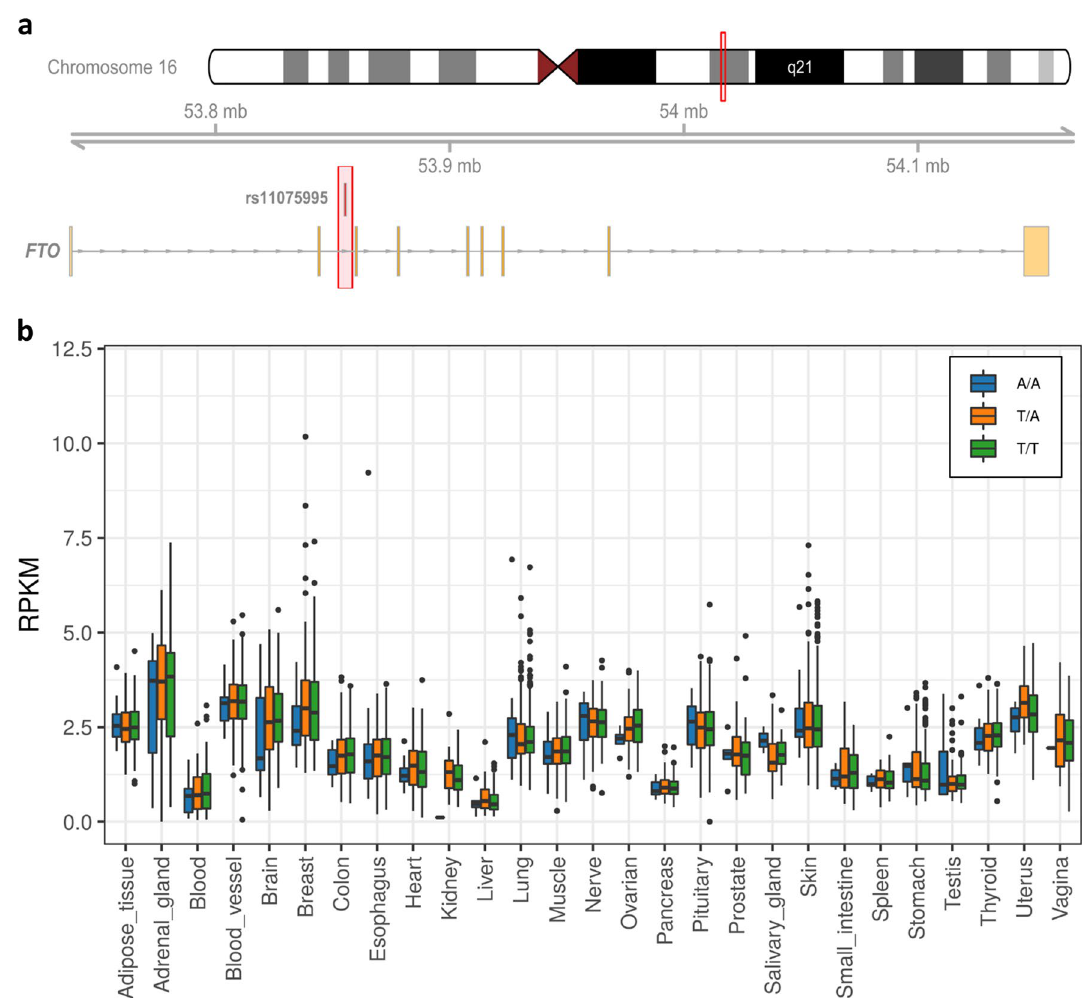
Figure 7. cis-effects of rs11075995 minor allele and FTO expression. ( a ) Ideogram and chromosomal location of the rs11075995 variant within in the second intron of the FTO gene. ( b ) Tissue-specific expression of FTO stratified by genotypes at the rs11075995 location. T/T homozygous major allele (Green), A/T heterozygous (Orange), A/A homozygous minor allele